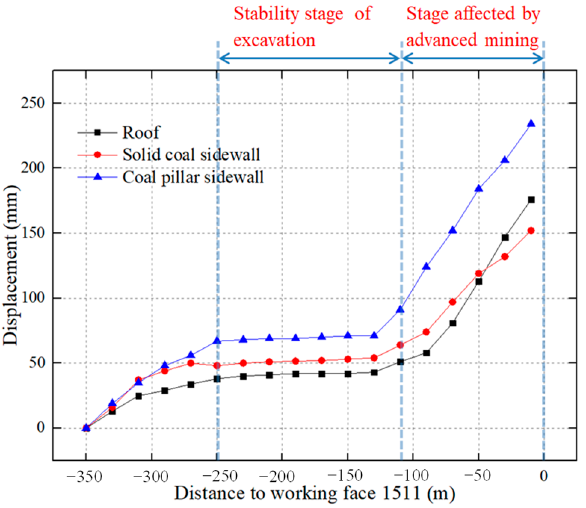
Figure 11. Surface displacement law of surrounding rock in zone A of MTR 1513.